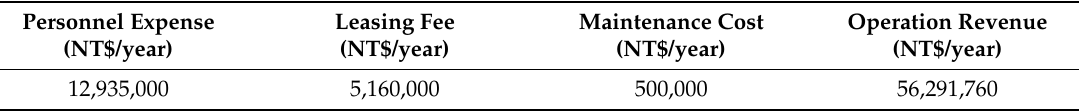
Table 5. Economic analysis parameters for the charging